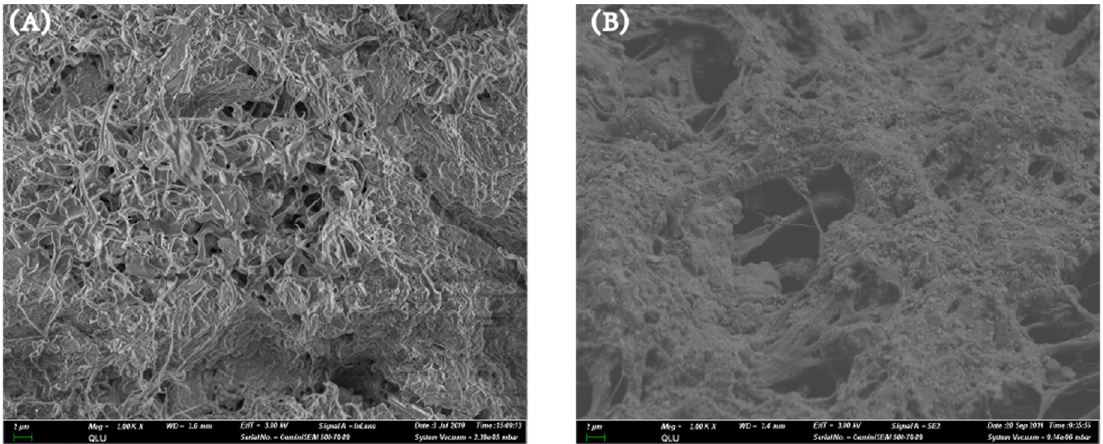
Figure 4. The SEM microphotographs of cross-section for alkaline polymer electrolyte membranes of ( A ) PVA/KOH/MCC1 and ( B ) PVA/KOH/QMCC1.